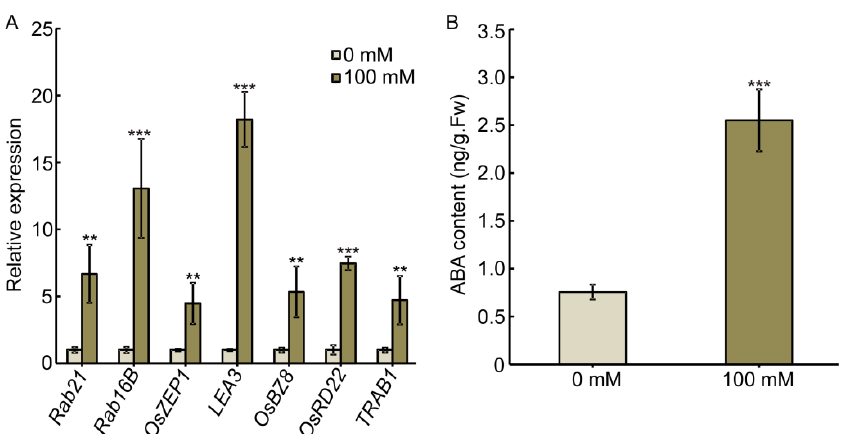
Figure 2. Salt stress promotes ABA accumulation in primary roots. ( A ) Expression of ABA-responsive genes in 4-day-old seedling root. RNA was isolated from roots for quantitative polymerase chain reaction (qPCR) analysis. Three biological replicates were performed with similar results, and a representative experiment is shown. Samples were collected from three independent experiments. Bars indicate ± SD. ( B ) ABA content in 4-day-old primary root with or without 100 mM NaCl treatment. Bars indicate ± SD of three biological replicates. The asterisks indicate significant differences compared to 0 mM NaCl (** p < 0.01, *** p < 0.001, Student’s t